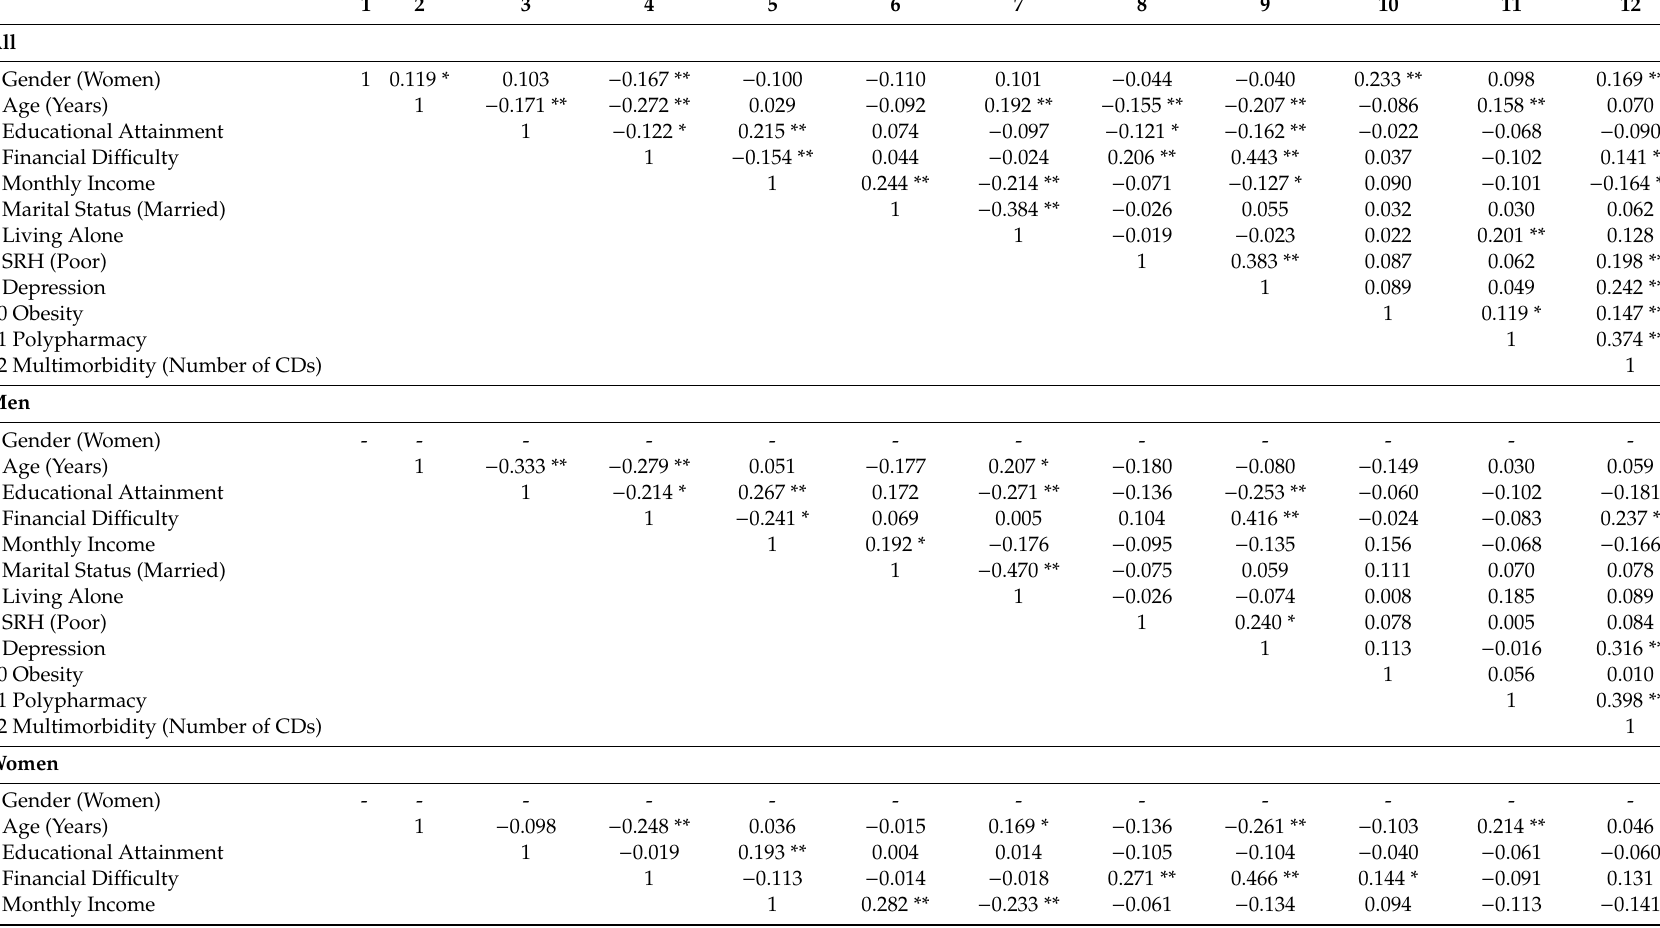
Table 2. Bivariate associations between study variables overall and by